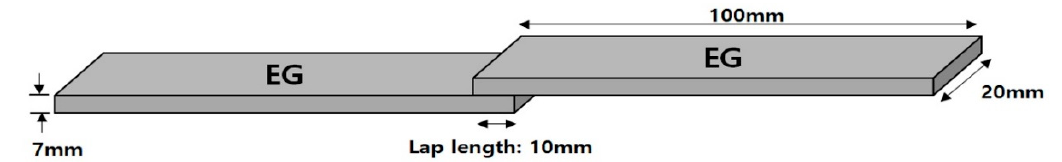
Figure 3. Sample dimensions for the tensile shear test.